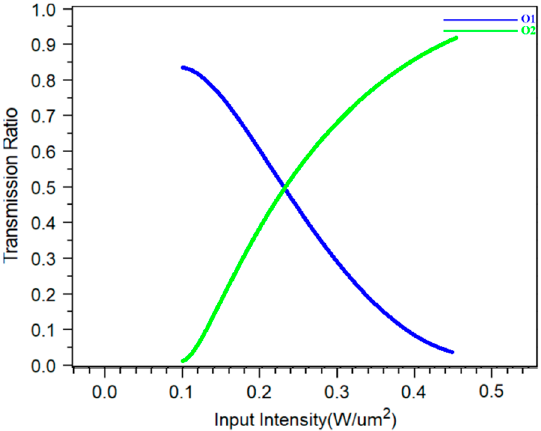
Figure 4. Transmission ratio of the structure for different input intensities.